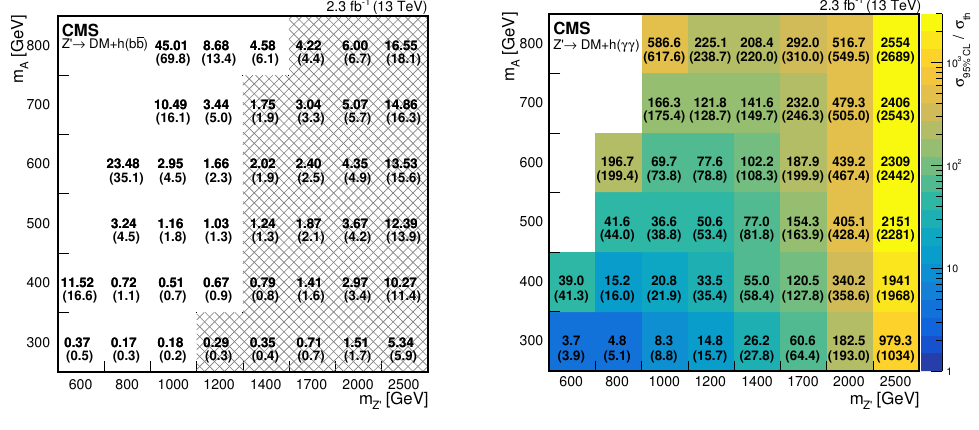
Figure 10 . The observed (expected) 95% CL limits on the signal strength (as in (cid:12)gure 9 right), separately for the h ! bb (left) and h ! (cid:13)(cid:13) (right) decay channels, and for m A = 300{800 GeV and m Z 0 = 600{2500 GeV. Other parameters for this model are (cid:12)xed to m (cid:31) = 100 GeV and tan (cid:12) = g (cid:31) = 1. The theoretical cross sections are calculated using g Z 0 = 0 : 8. For h ! bb, the results for the resolved analysis are shown over a white background, whereas the boosted analysis results are shown over a hatched